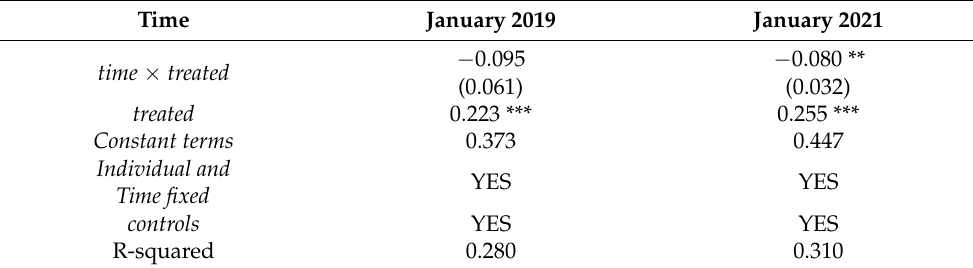
Table 7. Counterfactual Testing.